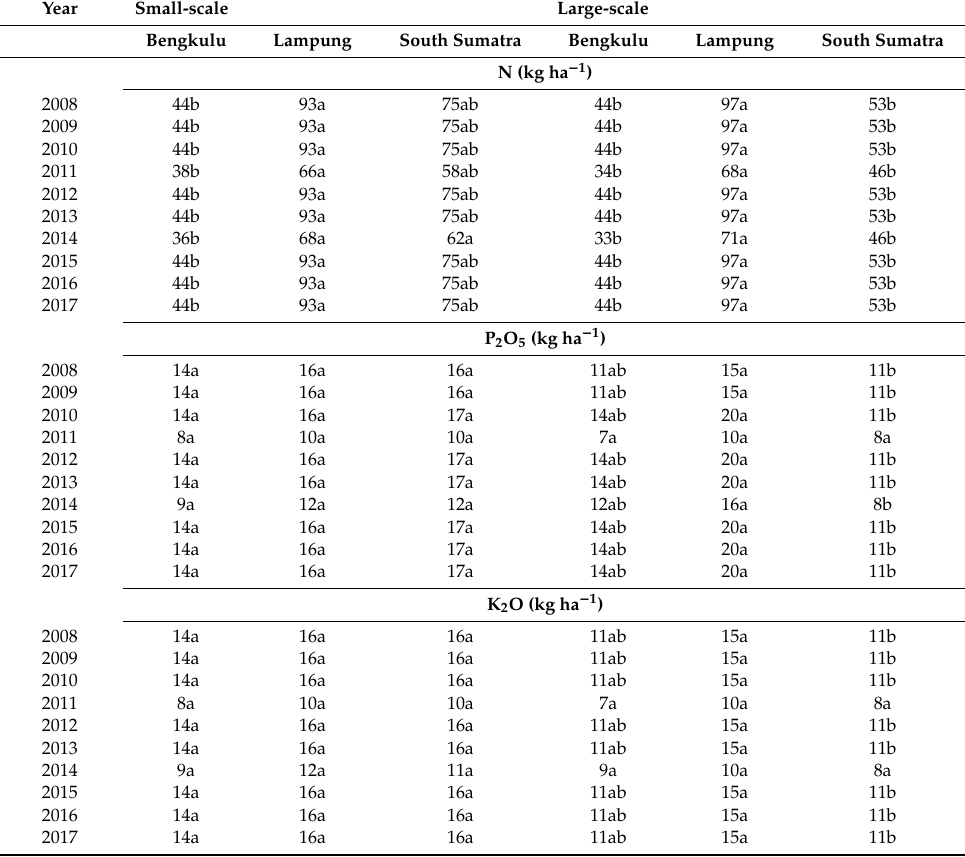
Table 6. Comparison of fertilizer use between provinces in small- and large-scale farms in Indonesia during 2008–2017. For a given farm size group, numbers with similar letter in a given row are not statistically di ff erent ( p >